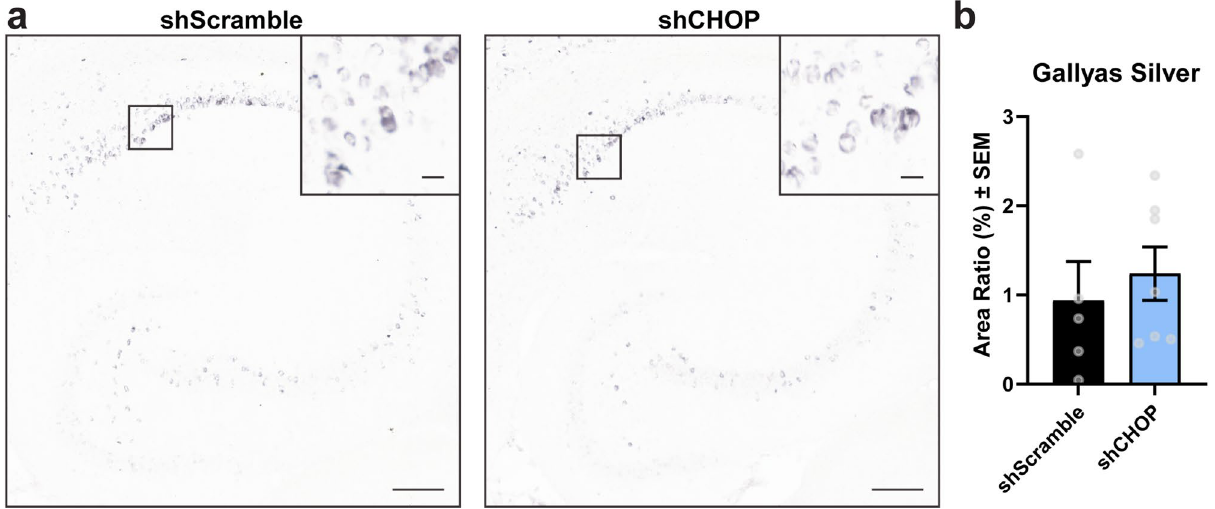
Figure 5. Tau tangles are not affected by CHOP. ( a ) Representative images and ( b ) analysis from hippocampal sections stained for Gallyas silver-positive tau in 11-month-old rTg4510 mice expressing AAV9-shScramble